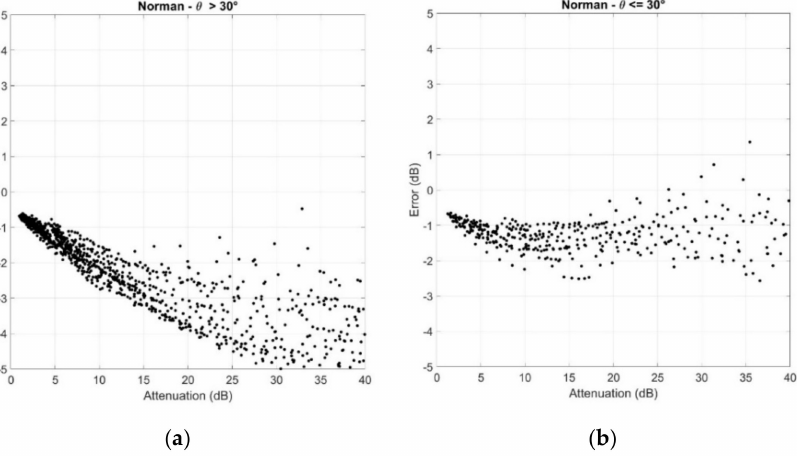
Figure A6. Scatter plots of the error ε = A SST , glo − A SST versus A SST : ( a ) θ > 30 ◦ ; ( b ) θ ≤ 30 ◦ .